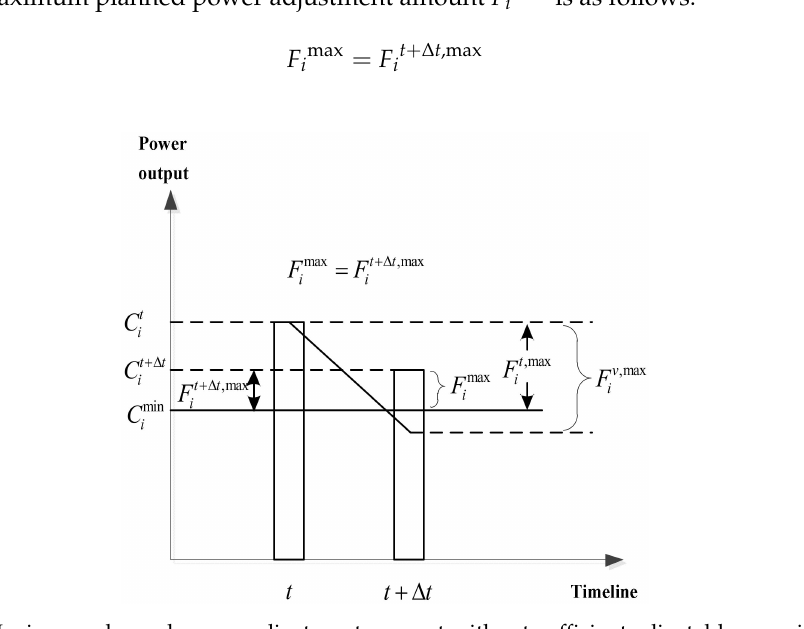
Figure 5. Maximum planned power adjustment amount without su ffi cient adjustable capacity when reduction of power supply is